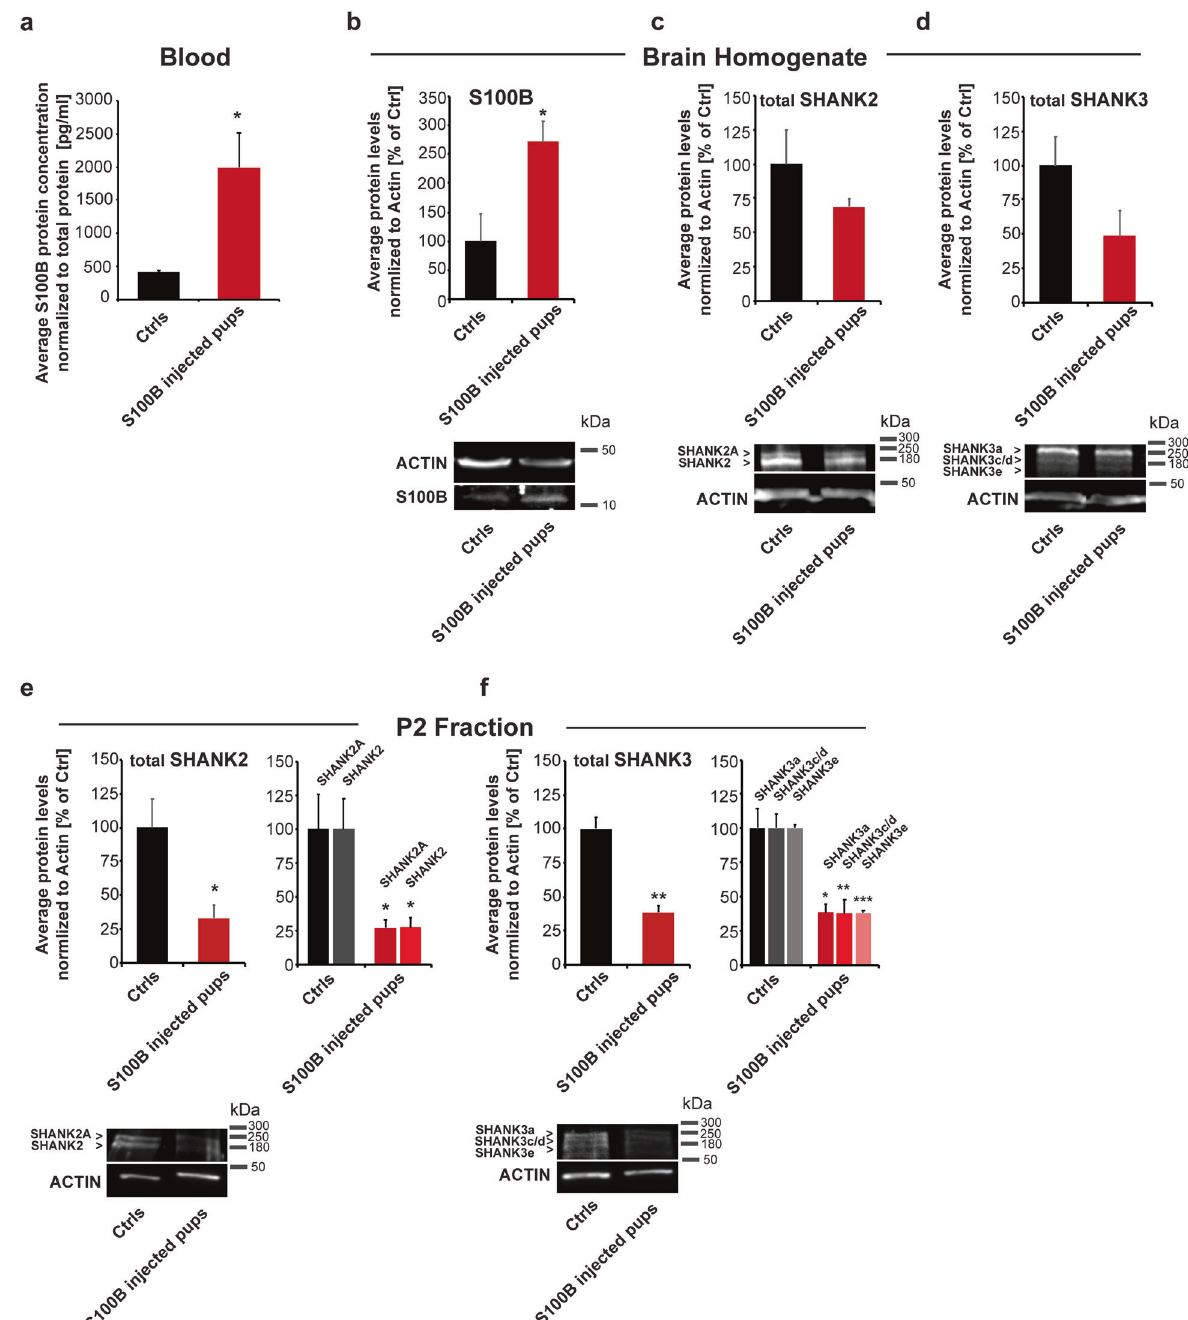
Fig. 4 Elevated S100B levels in blood and brain of mice exposed to S100B in utero and decreased synaptic SHANK2 protein concentrations. a Increased blood S100B levels were detected in pups using S100B speci fi c Luminex MAGPIX assays and normalized to the sample ’ s total protein concentration measured by BCA assays ( t -test, p = 0.0343). b Western blot analysis of whole-brain lysate of pups from Ctrls and S100B mothers reveals signi fi cantly higher levels of S100B in the brain of pups exposed to S100B ( t -test, p = 0.0432; n = 3 per group). c, d Western blot analysis of whole-brain homogenate of pups from Ctrls and S100B-injected mothers reveals no signi fi cant changes in SHANK2 ( c ) and SHANK3 ( d ) in the brain of pups exposed to S100B. e, f Using crude membrane (P2) fractions, we detected signi fi cantly lower synaptic SHANK2 levels ( e ) in S100B pups compared to Ctrls ( t -test, p SHANK2 = 0.046; n = 3 per group). Both isoforms (SHANK2A and SHANK2) were similarly affected (right panel ( t -test, p SHANK2A = 0.0487; p SHANK2 = 0.0362; n = 3 per group)). f The levels of total SHANK3 were signi fi cantly reduced ( t -test, p SHANK3 = 0.0018; n = 4 Ctrls, n = 3 S100B) in S100B pups compared to Ctrls. All higher MW isoforms (SHANK3a, SHANK3c/d and SHANK3e) were similarly affected (right panel ( t -test, p SHANK3a = 0.0487; p SHANK3c.d = 0.0362; p SHANK3c.d = Interestingly, S100B secretion can be enhanced by the pro- risk factor for the development of ASD [53 – 57]. Maternal immune in fl ammatory cytokine IL-6 [14]. Besides the ability to bind activation (MIA) in mice, often produced by injection of lipopoly- calcium, S100B can bind two zinc ions per homodimer saccharide (LPS), acts as a nongenetic factor in the etiology of ASD via [17, 59, 60]. Intriguingly, prenatal zinc supplementation reduced elevated IL-6 levels [58].